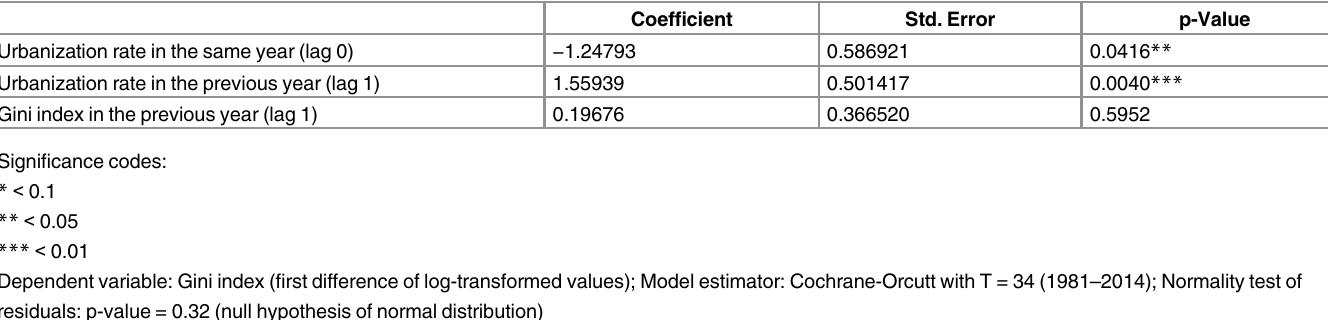
Table 3. Summary of AR(1)